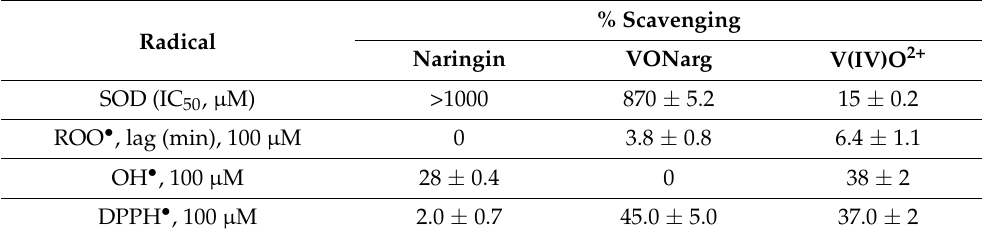
Table 3. Percentage of free radical scavenging of naringin, VONarg, and oxidovanadium(IV) cation. Values are expressed as the mean ± standard error of at least three independent